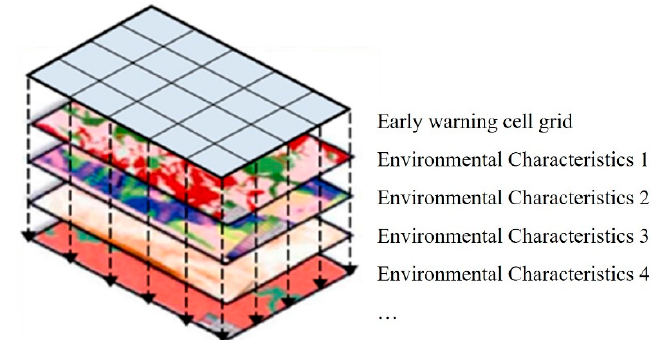
Figure 5. Schematic diagram of spatial superposition analysis.